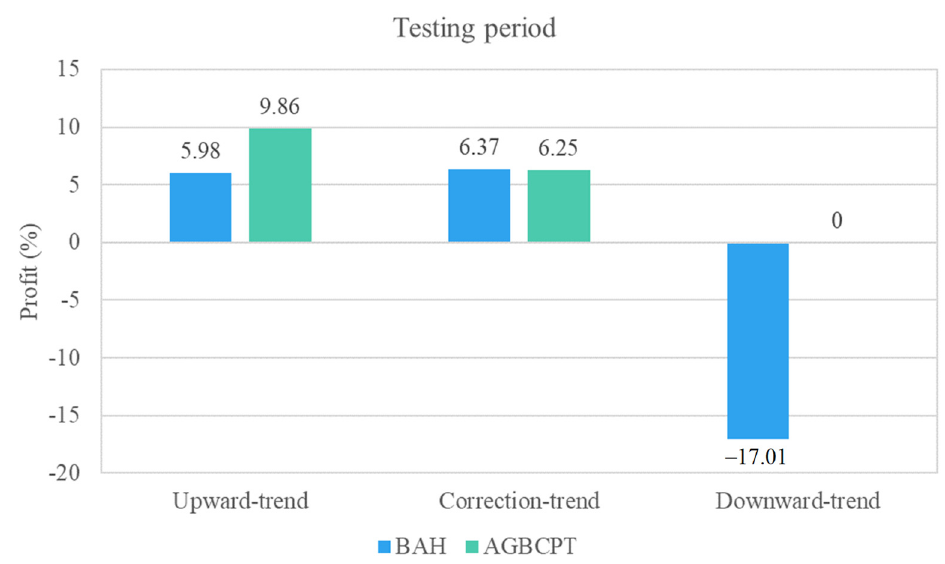
Figure 13. AGBCPT and BAH testing results.